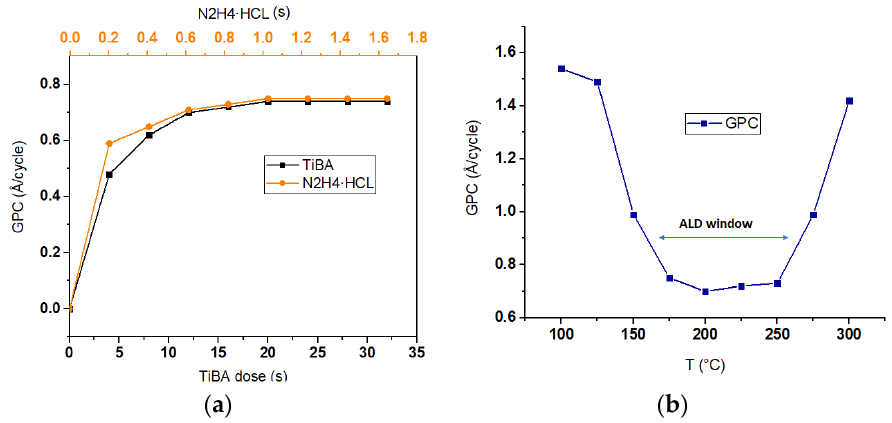
Figure 2. Growth per cycle (GPC) as a function of ( a )—precursor exposure time; ( b )—deposition temperature.